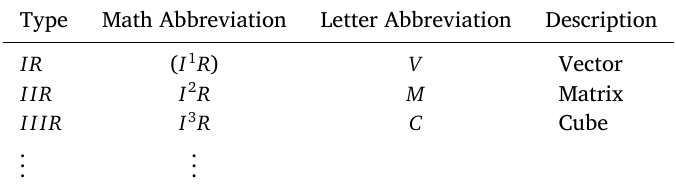
Vector types and their